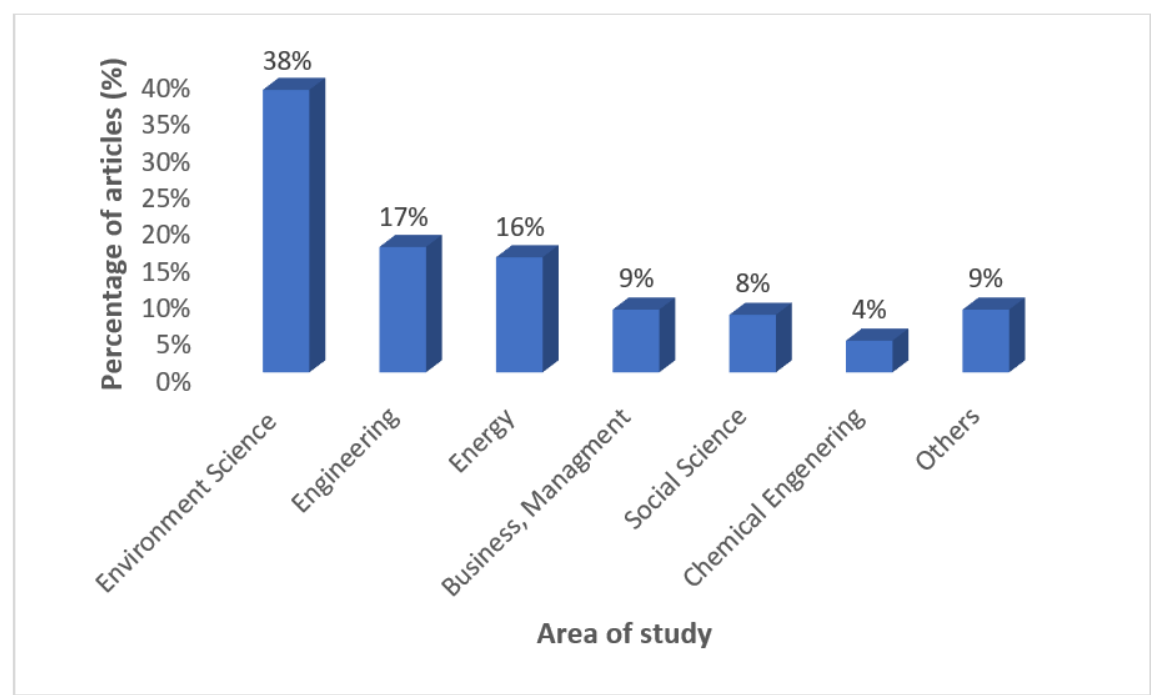
Figure 4. Distribution of data by area of study.